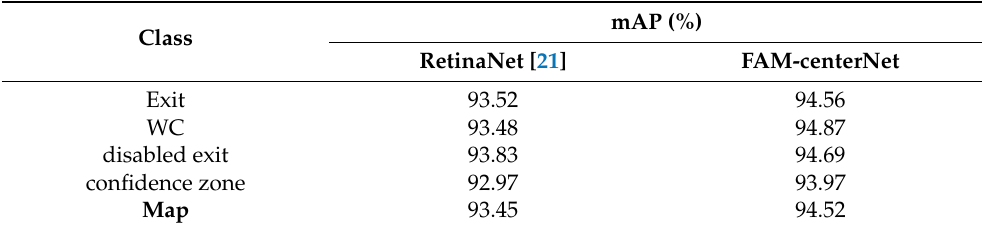
Table 5. Comparison against the state-of-the-art model.